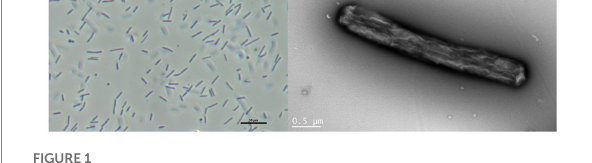
FIGURE 1 Cell morphology of Tenacibaculum sp. LAR25 as observed by light and electron microscopy. (A) Phase-contrast micrograph of fresh culture of the bacteria in LB broth showing both elongated and spherical cells. (B) Negatively stained cell of the novel bacterium observed with